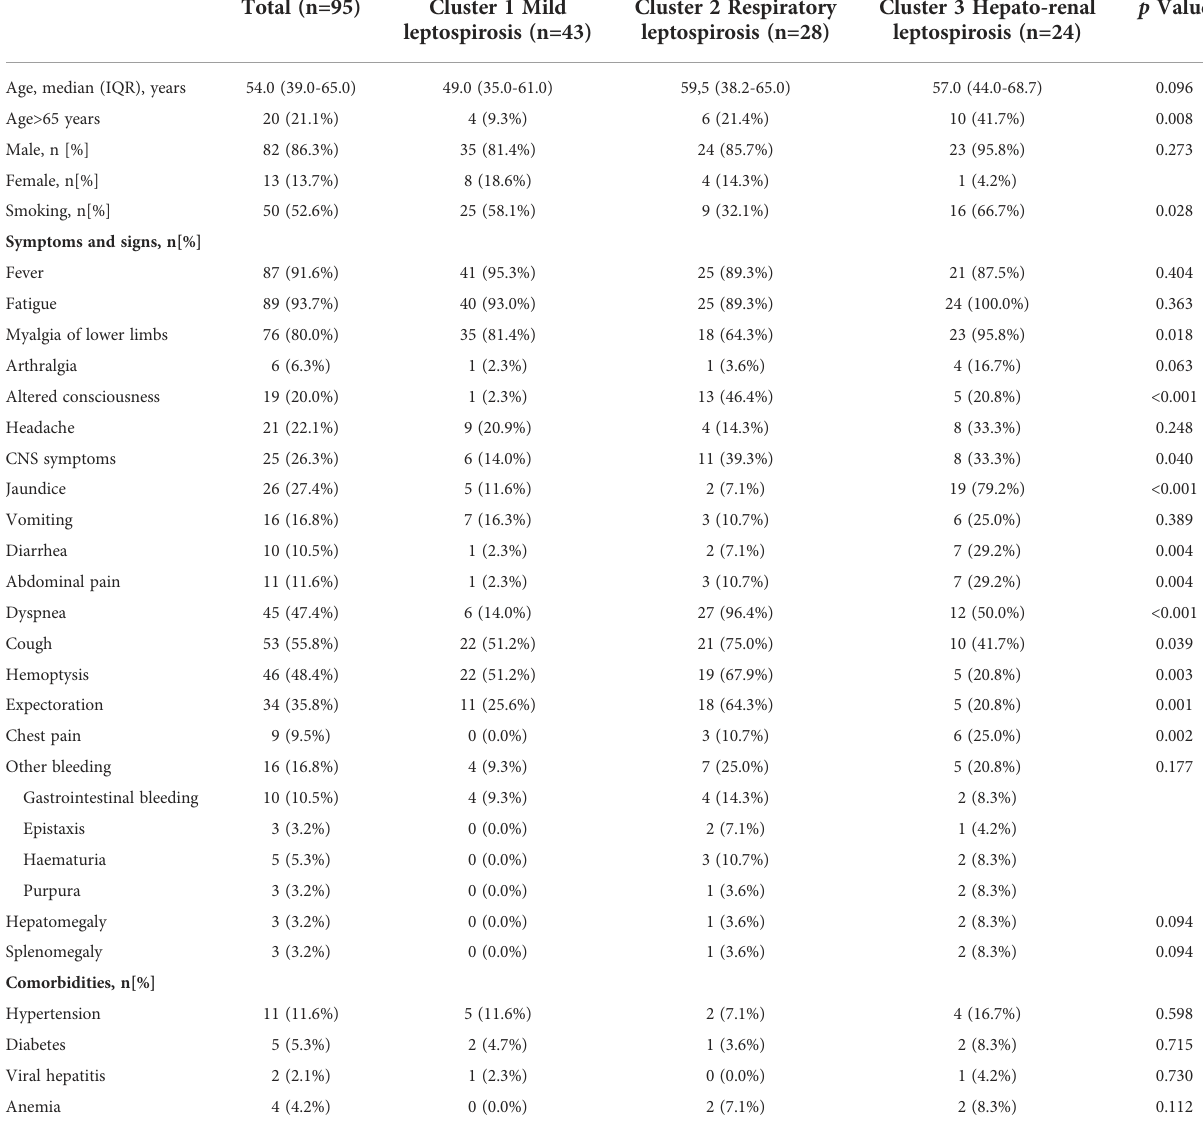
TABLE 1 Clinical manifestations of different